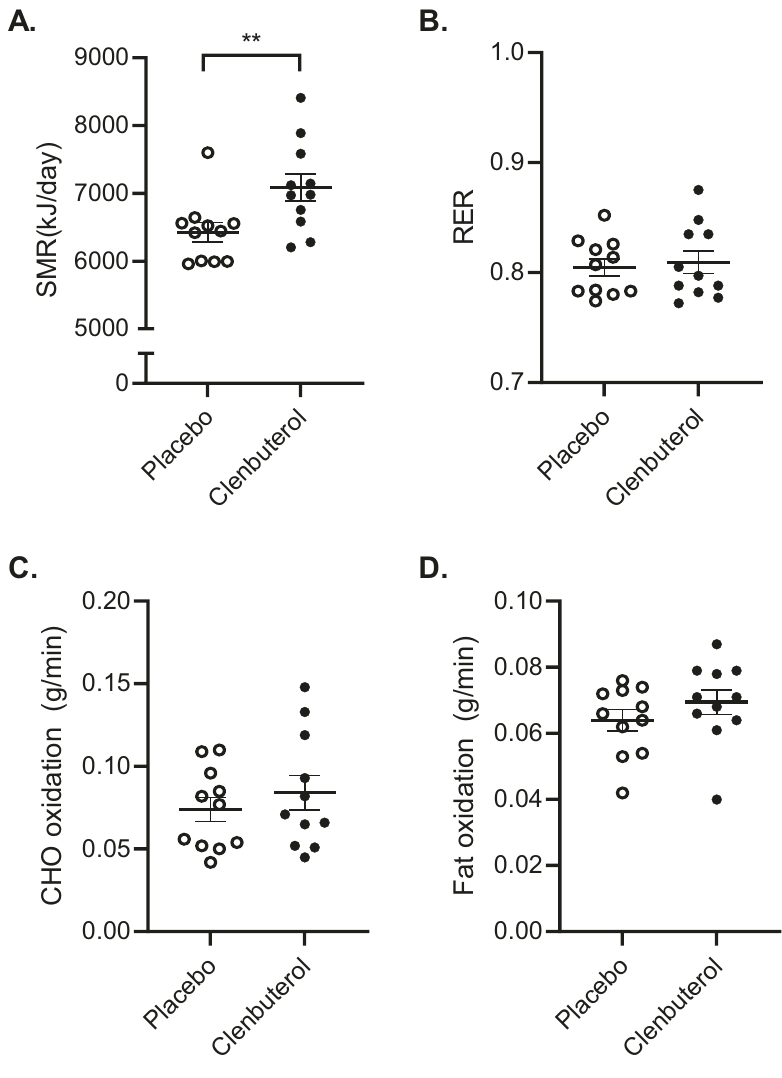
Fig. 5 | Prolonged clenbuterol treatment enhances sleeping metabolic rate independentofselectiveincreasesinsubstrateoxidation.A Sleepingmetabolic rate (SMR) (kJ/min) ( p =0.002). B Respiratory exchange ratio. C Carbohydrate oxidation during the night (g/min). D Fat oxidation during the night (g/min). SMR